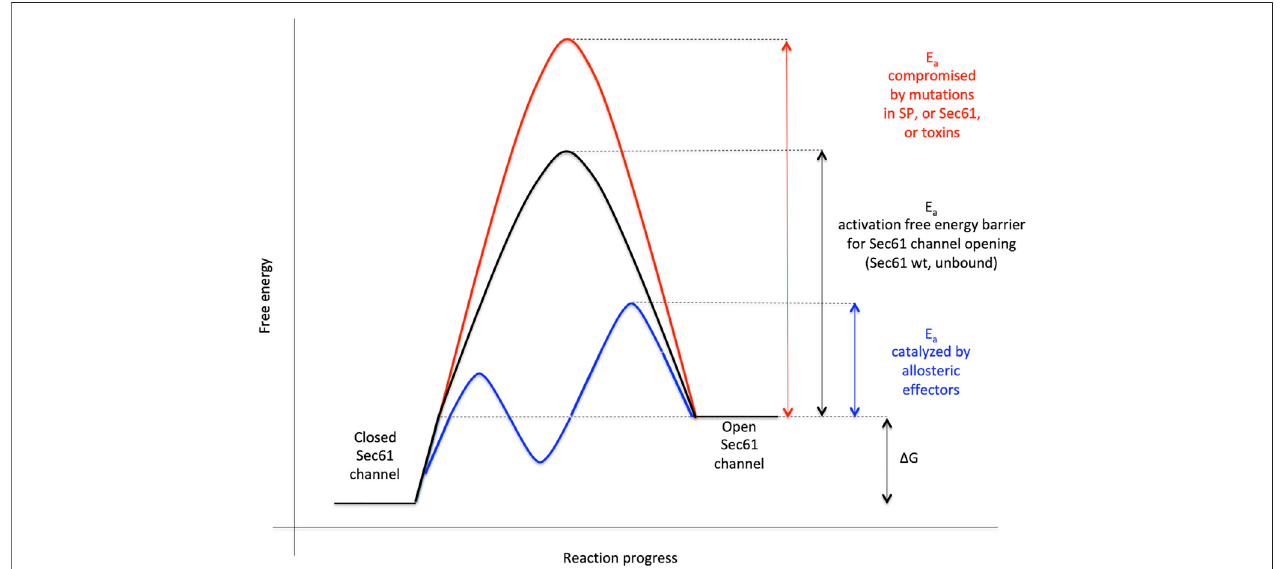
FIGURE 7 | Energetics and kinetics of Sec61 channel gating. In our view, the TRAP- or Sec62/Sec63 +/- BiP-mediated Sec61 channel gating is best visualized in analogy to an enzyme-catalysed reaction. Accordingly, TRAP, Sec62, Sec63 or BiP reduce the energetic barrier for full channel opening, which can apparently be reinforced by Sec61 channel inhibitors, such as cyclic heptadepsipeptides (such as CAM741) or certain eeyarestatins (such as ES24) (Pauwels et al., 2021; Pauwels et al.,2022).AtleastinthecaseofES24,bindingoftheinhibitorwithinthechannelporearreststhechannelinapartiallyopenstate,whichmaybeidenticalwiththe primed state and is compatible with Ca 2+ -ef fl ux but not with full channel opening for protein translocation (Gamayun et al., 2019; Bhadra et al., 2021b). TRAP and BiP contribute to full channel opening by direct interaction with ER lumenal loops 5 and 7, respectively, of Sec61 α ( Figure 1D ). SEC61A1 mutations can increase the free energybarrierforchannelopening perse (V67G,V85DandQ92Rmutation)orindirectly,suchasbyinterferingwithBiPbinding(Y344Hmutation)(forrecentreviewssee Sicking et al., 2021a; Tirincsi et al., 2022a). Notably, all these effects are precursor speci fi c because the amino-terminal SPs are either ef fi cient or inef fi cient in driving Sec61 channel opening by themselves. Typical for an enzyme-catalysed reaction, BiP can also support ef fi cient gating of the Sec61 channel to the closed state, i.e. the reverse reaction. The Figure and Figure legend were adapted from Sicking et al. (2021a).